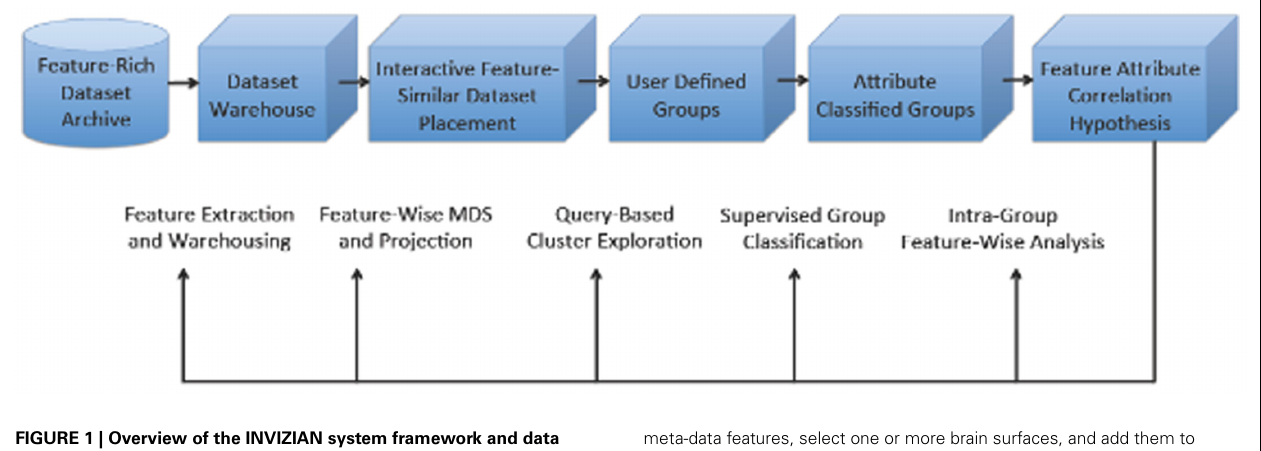
FIGURE 1 | Overview of the INVIZIAN system framework and data workflow. Given the contents of an anatomical neuroimaging database, multi-dimensional scaling (or other data reduction method) determines the placement of extracted brain surfaces in the INVIZIAN 3D environment.The user can dynamically interact with the elements in this space, search over